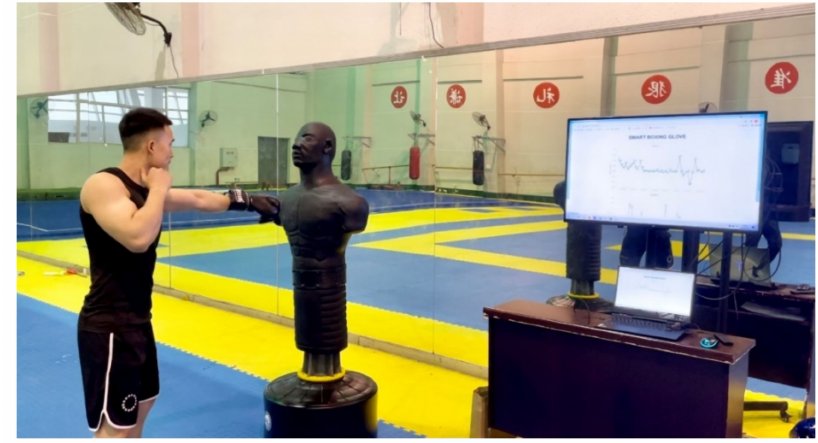
Figure 14. Image of the field test.